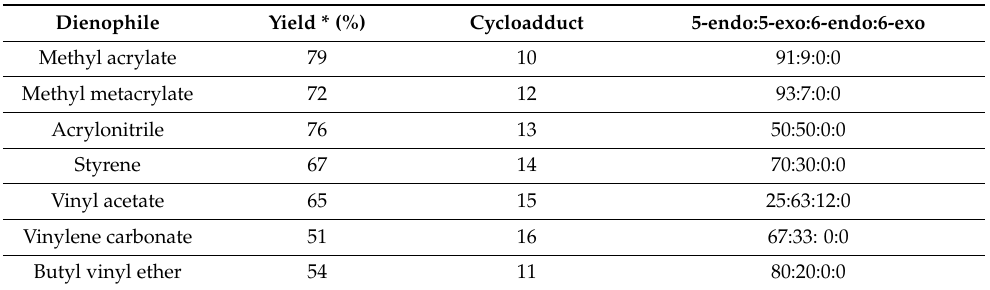
Table 1. Results from cyloadditions of 5-(BocNH)-2(H)pyran-2-one, 8, with various